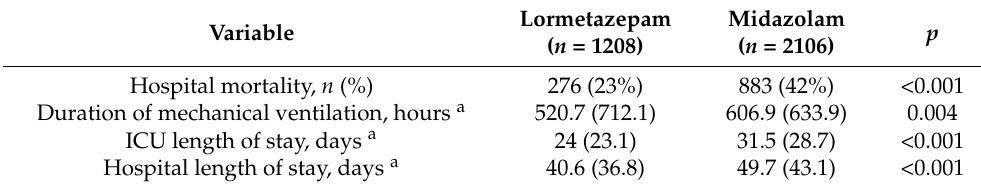
Table 4. Univariate comparison of outcome parameters for the midazolam group and the lormetazepam group.